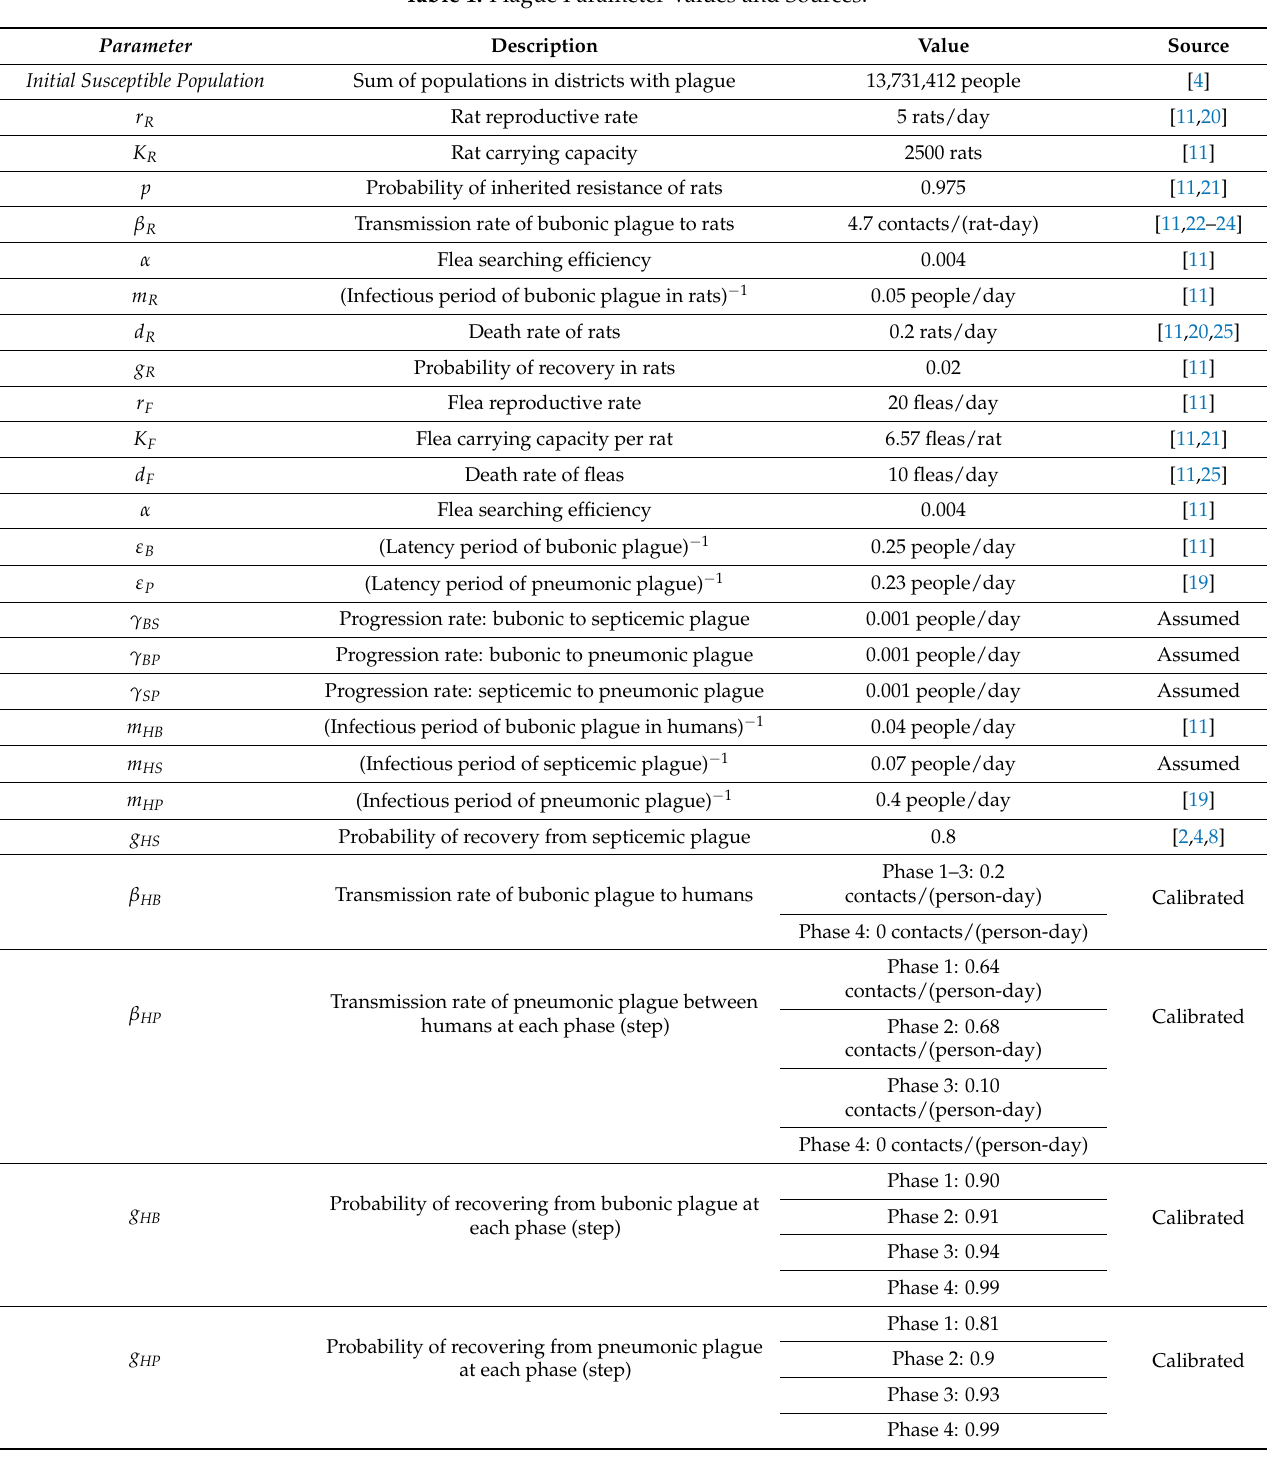
Table 1. Plague Parameter Values and